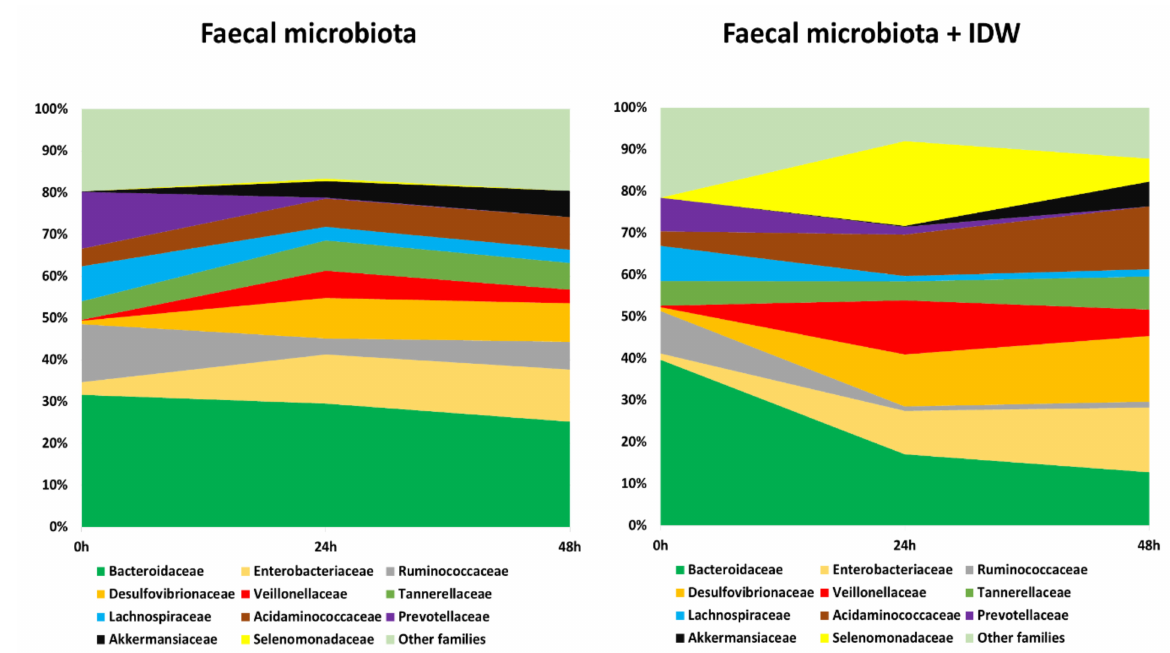
Figure 4. Evolution of bacterial families with relative abundance higher than 5% during fecal fermentations in the absence and in the presence of IDW (intestinal-digested